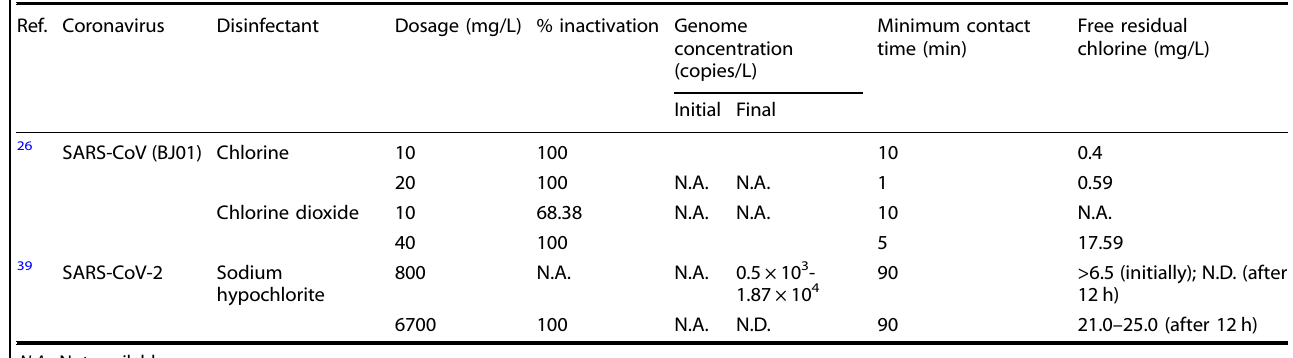
Table 6. The effect of disinfectant on the persistence of coronavirus in wastewater. Ref.